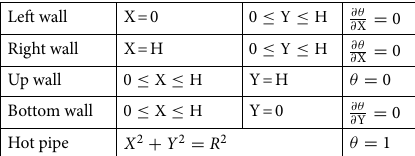
Table 2. Non-dimensional boundary conditions.